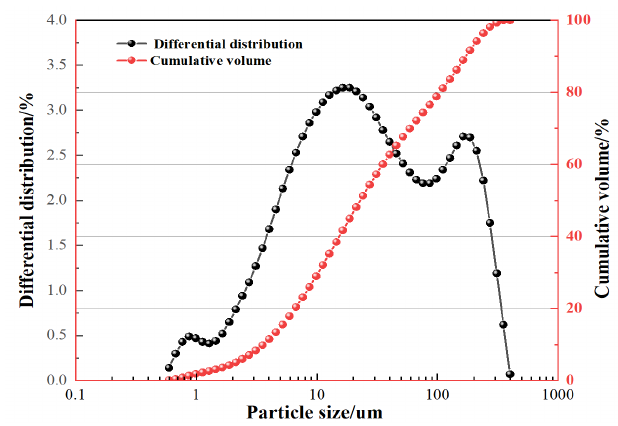
Figure 1. Particle size distribution of tailings and cement.